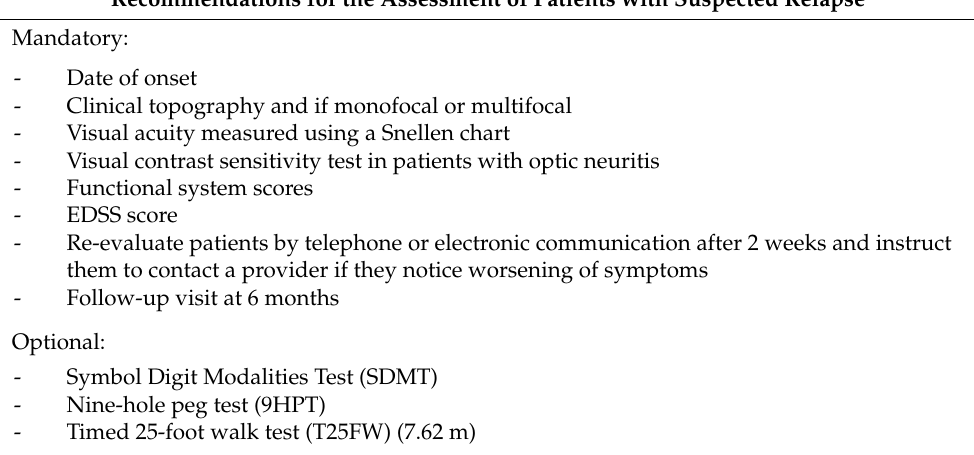
Table 1. Recommendations for the Assessment of Patients with Suspected Relapse.